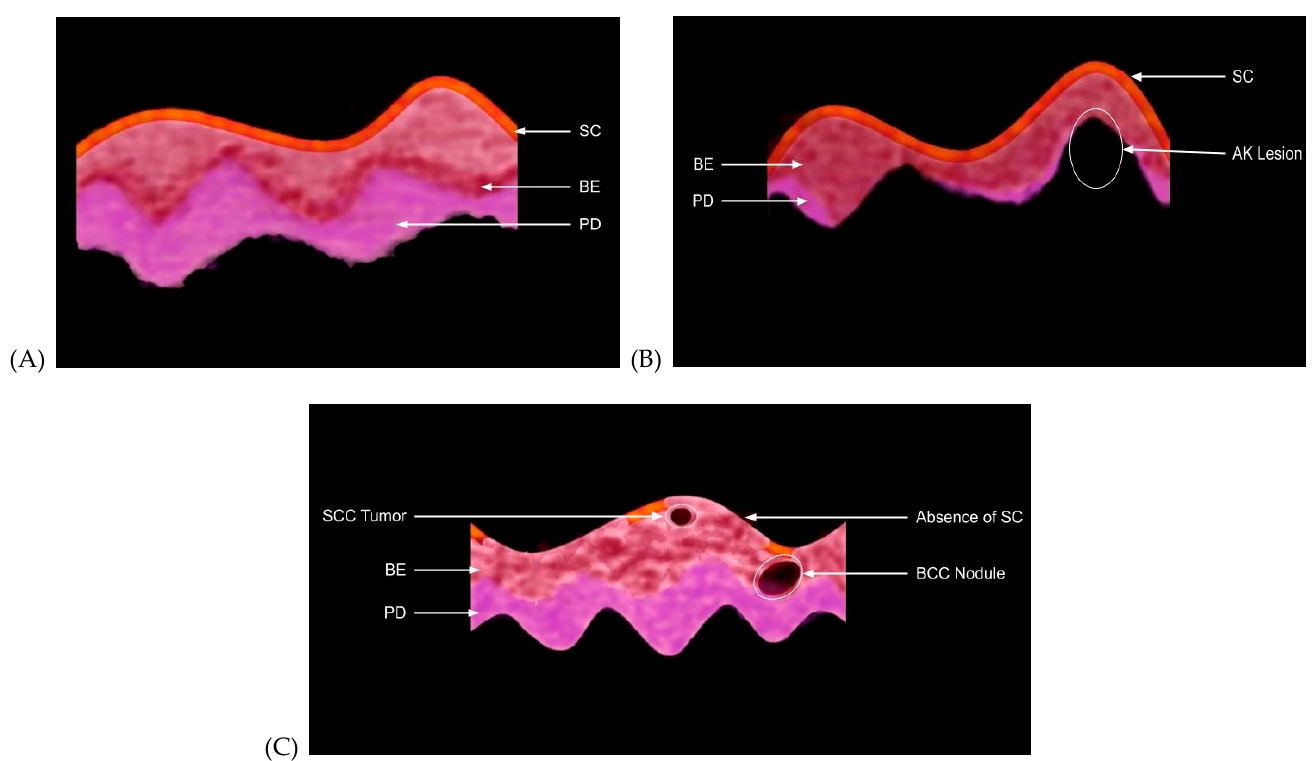
Figure 2. Schematic diagram of OCT color-coded images describing the differences between normal skin ( A ), AK, BCC and SCC ( B , C ) derived from previous study results [20,21]. Normal skin ( A ) contains an epidermis composed of a stratum corneum (SC) on top, an epithelial layer that derives from the basal cell layer (BE), rete pegs that undulate at the basal cell–papillary dermal layer interface (PD). The papillary dermis contains dermal collagen with a resonant frequency of 100 Hz. Pre- (AK) ( B ) and cancerous lesions ( C ) (BCC and SCC) contain nodular and linear tumors. Cancerous tumors (BCC and SCC) contain reduced amounts of stratum corneum and lack the undulating rete pegs. The dermal collagen fibers with a resonant frequency of 100 Hz are replaced by lesions with dense fibrous tissue (black spots) that reflect more light back to the detector. The stiffness of the tumor collagen can be determined by measuring the resonant frequency of the material in the black spots. Resonant frequency peaks in cancerous lesions occur at 260 Hz as a result of stiffening of the collagen deposited by tumor cells.